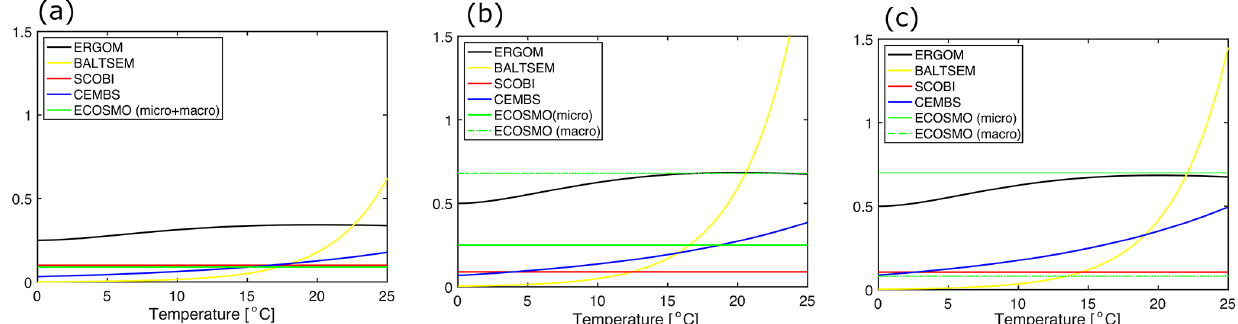
Figure 2. Maximum grazing rates in dependence of temperatures for (a) cyanobacteria, (b) diatoms, and (c) other phytoplankton (d − 1 ). Note that the BALTSEM model prescribes zero grazing of diatoms in autumn. The values for the ECOSMO and SCOBI models refer to the product of max. zooplankton growth rate and food preference for the respective phytoplankton functional groups and the temperature effect. The two values for the ECOSMO model refer to their two zooplankton groups: micro- and macro-zooplankton. All parameter values refer to the respective references provided in Table 4. Note that the link to phytoplankton biomass differs considerably between the models, and a direct comparison of the curves is not necessarily